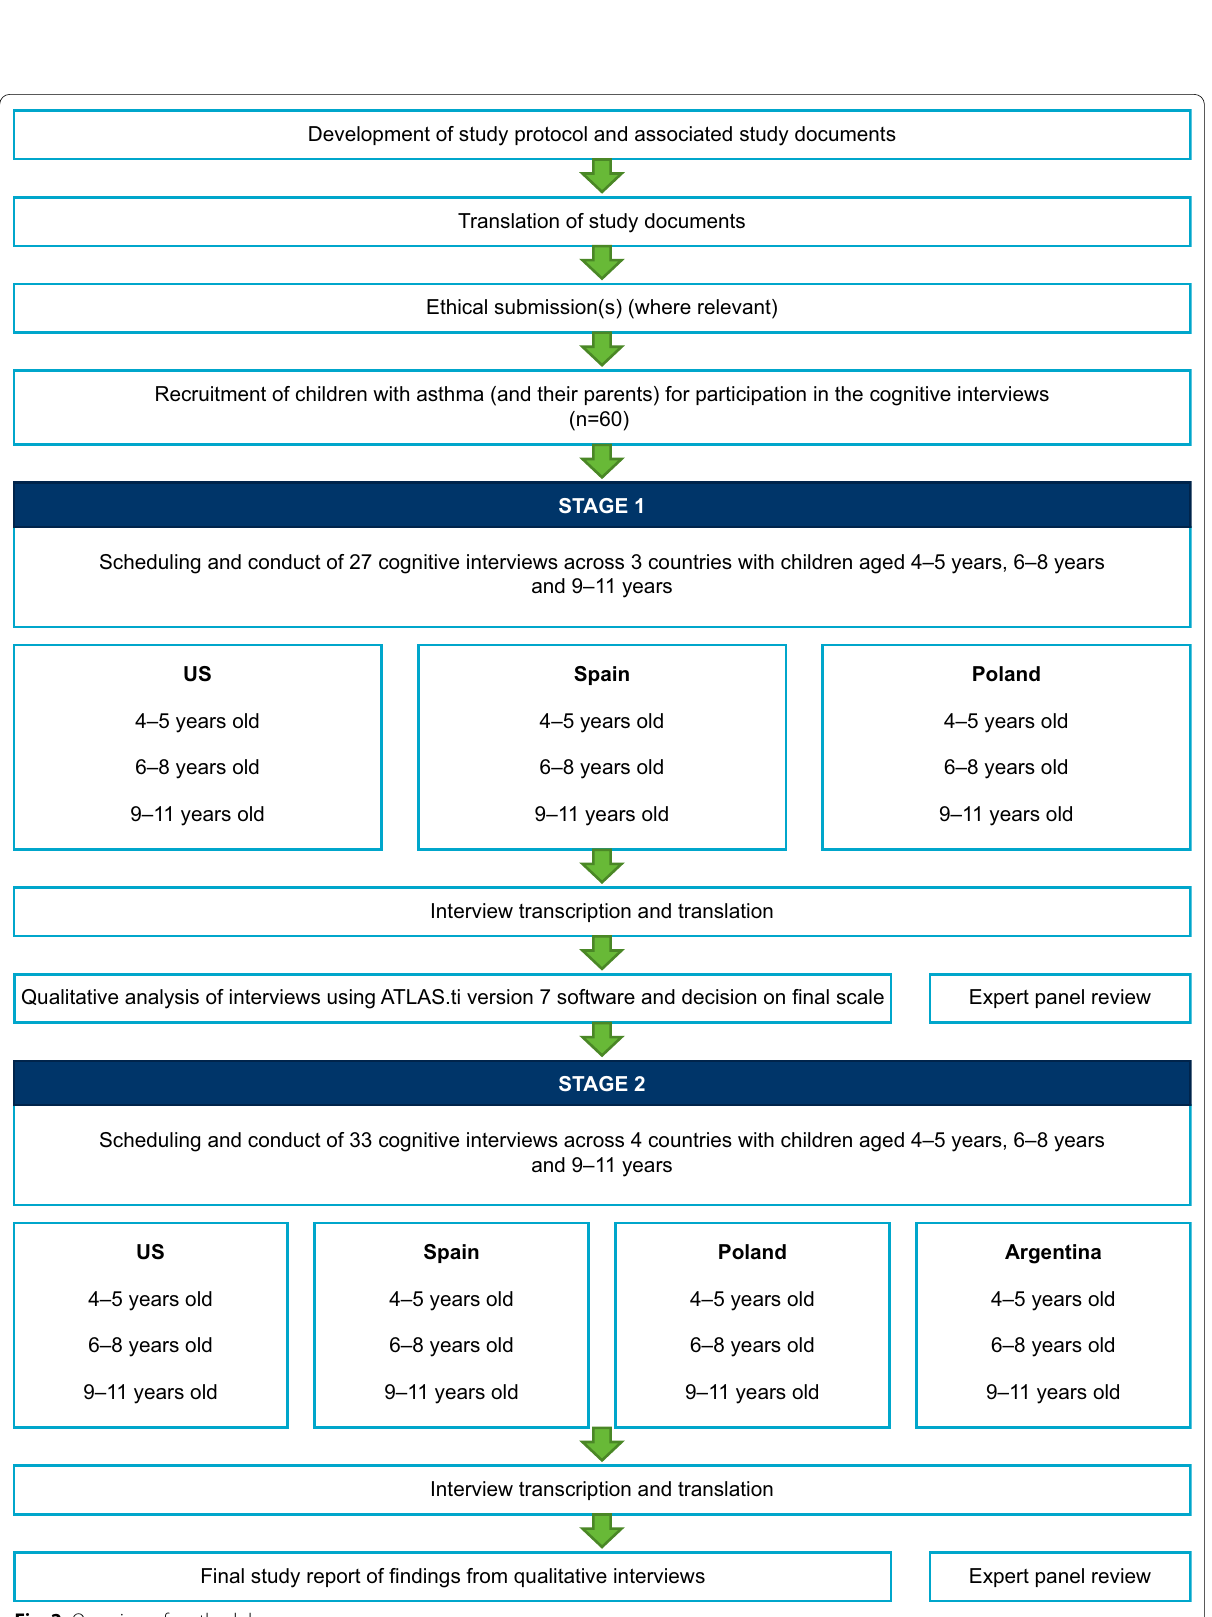
Fig. 2 Overview of